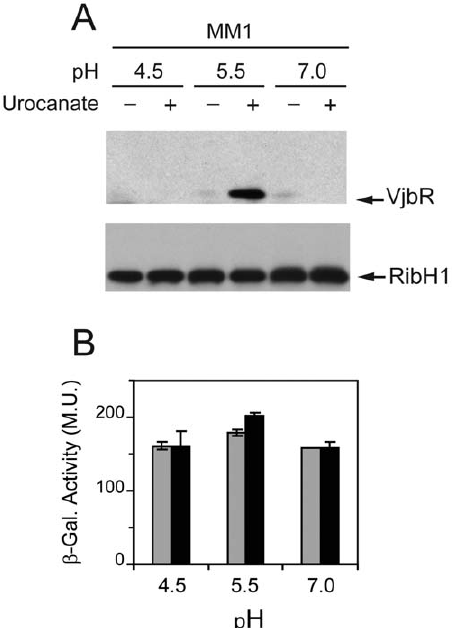
Figure 2. Analysis of expression of VjbR under different acidic and metabolic conditions. (A) B. abortus 2308 wild type strain was grown in TSB until OD 600 # 1.5. Subsequently, cultures were centrifuged and bacteria were resuspended in medium MM1 at pH 4.5, 5.5, or 7.0; in the absence or presence of 5 mM urocanic acid, as indicated. After incubation under different conditions, OD 600 was determined, and samples were analyzed by western blot using anti-VjbR or anti-RibH1 polyclonal antibodies. Results are representative from one of three independent experiments. (B) Analysis of the vjbR promoter activity. Strain B. abortus P vjbR - lacZ was cultured in TSB and shifted to MM1 at pH 4.5, 5.5, or 7.0; in the absence (gray bars) or presence (black bars) of 5 mM urocanic acid. Subsequently, b -galactosidase activities were determined. Values are means 6 standard deviations of duplicate samples from a representative of three independent experiments.